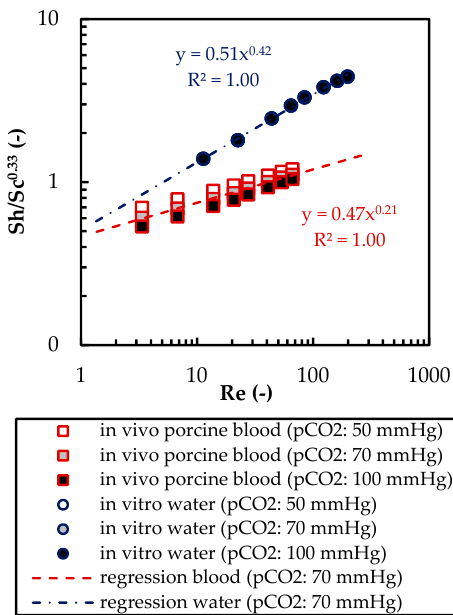
Figure 19. Sherwood correlations for porcine blood and water determined via the CFD results.